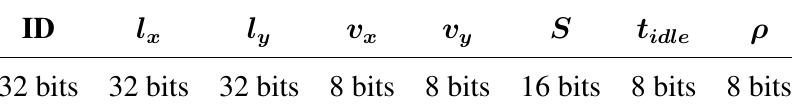
Table 1. Hello messages (HMs) format in the multimetric map-aware routing